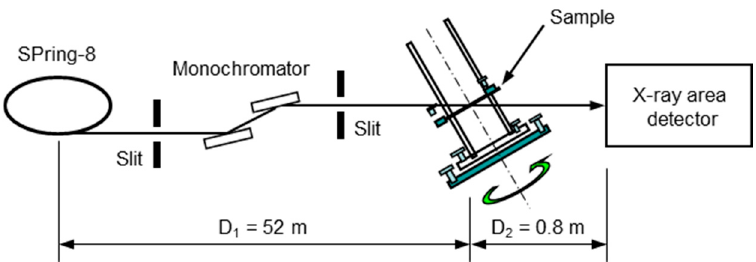
Figure 10. The SR-based CL setup at BL19B2 of SPring-8.